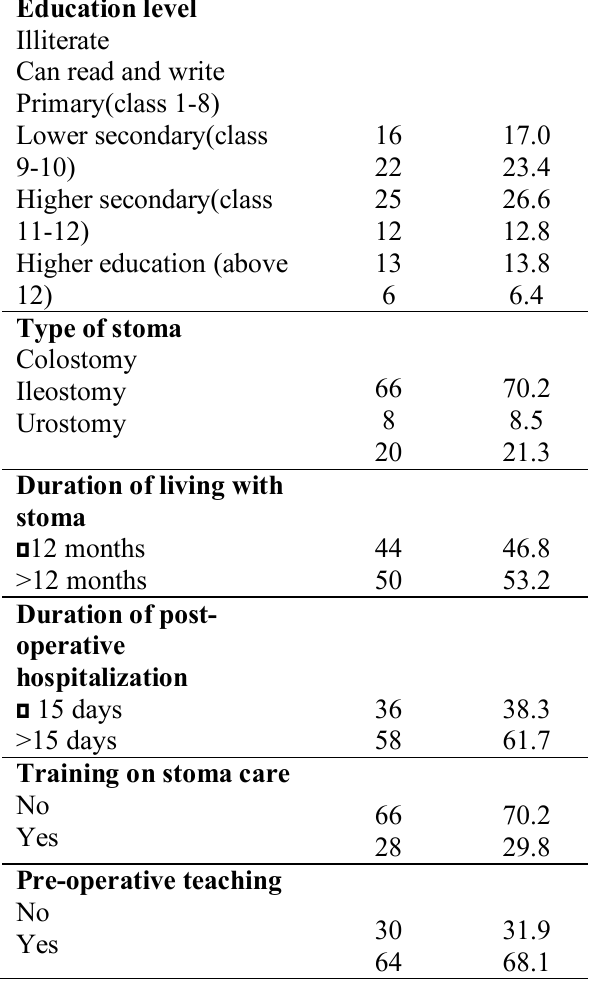
Table 1: Socio-demographic information: